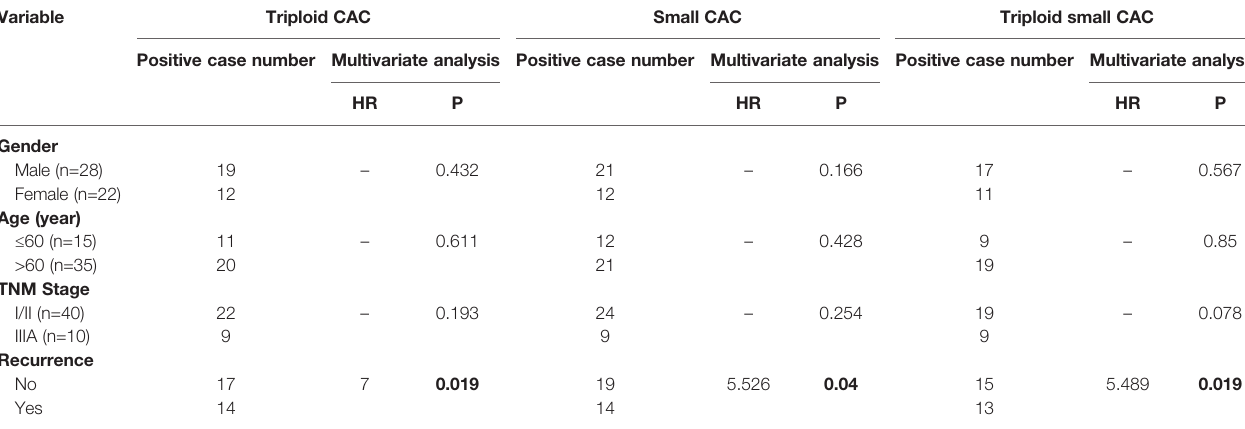
TABLE 4 | Logistic regression analysis of CAC and clinicopathologic characteristics among 50 patients with resectable NSCLC. Variable Triploid CAC Small CAC Triploid small